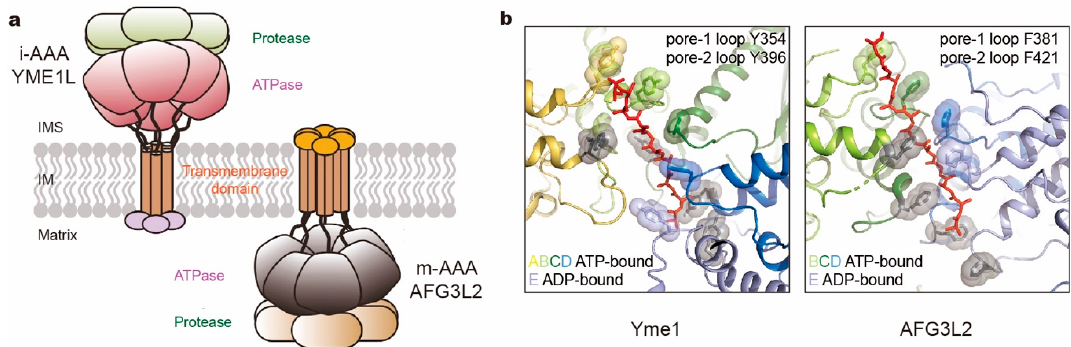
Figure 6. Comparison of two kinds of mitochondrial membrane-anchored AAA + proteases. ( a ) Cartoon representation of i- and m-AAA proteases anchored in the mitochondrial inner membrane (IM) with opposite orientations to intermembrane space (IMS) and matrix space, respectively. ( b ) The pore loop spiral staircases surrounding the substrate in yeast Yme1 (PDB ID: 6AZ0; left) and human AFG3L2 (PDB ID: 6NYY; right). Aromatic residues in pore loops are all highlighted as sticks and spheres, which in pore-2 loops are colored gray.